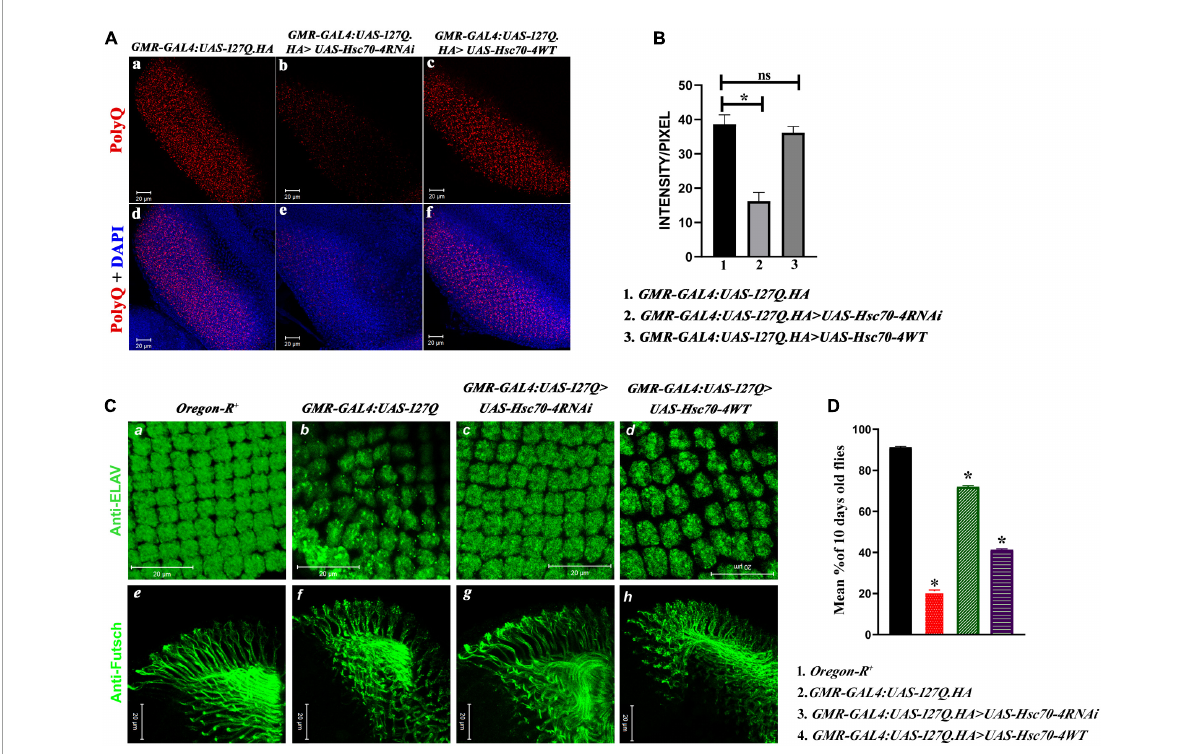
FIGURE3 hsc70-4 downregulation reduces the aggregates accumulation, resulting in the improved arrangement of rhabdomeres and optic neurons. Thus, it enhances the phototaxis response. (A) The panel shows the PolyQ aggregates (in red) accumulation in (a) GMR-GAL4:UAS-127Q ; (b) GMR-GAL4:UAS-127Q > UAS-Hsc70-4RNAi; (c) GMR-GAL4:UAS-127Q > UAS-Hsc70-4WT . Panels (d–f) from the panel (A) show the nuclei staining (in blue) along with the aggregates of the respective genotypes (scale bar 20 µ m). (B) Quantitative analysis of the intensity/pixel of the immunofluorescence images shows PolyQ aggregates accumulation in the different genotypes from three independent experiments and data shown as ± SEM (ns indicates insignificant change at p -value ≤ 0.05%, and * indicates the significance at a p-value of ≤ 0.05). (C) hsc70-4 downregulation restores the rhabdomere arrangement and the axonal connection disruption in GMR-GAL4:UAS-127Q -driven flies. (a,e) Oregon-R + , (b,f) GMR-GAL4:UAS-127Q , (c,g) GMR-GAL4:UAS-127Q > UAS-Hsc70-4RNAi , (d,h) GMR-GAL4:UAS-127Q > UAS-Hsc70-4WT . Anti-ELAV (in green) to mark rhabdomere and 22C10 staining against Futsch (in green) to visualize the optic neurons (scale bar 20 µ m). (D) The graph shows the phototaxis response in the 10-day-old flies of Oregon-R + , GMR-GAL4:UAS-127Q , GMR-GAL4:UAS-127Q > UAS-Hsc70-4RNAi , and GMR-GAL4:UAS-127Q > UAS-Hsc70-4WT (the experiment was performed in triplicate where n ≥ 100 for each genotype, and data are shown as ± SEM; * indicated significance at the p -value of ≤